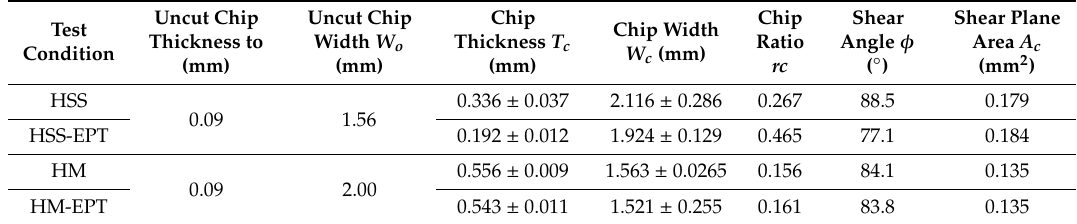
Table 3. Cutting geometry values, shear angle φ , and shear plane area A c .